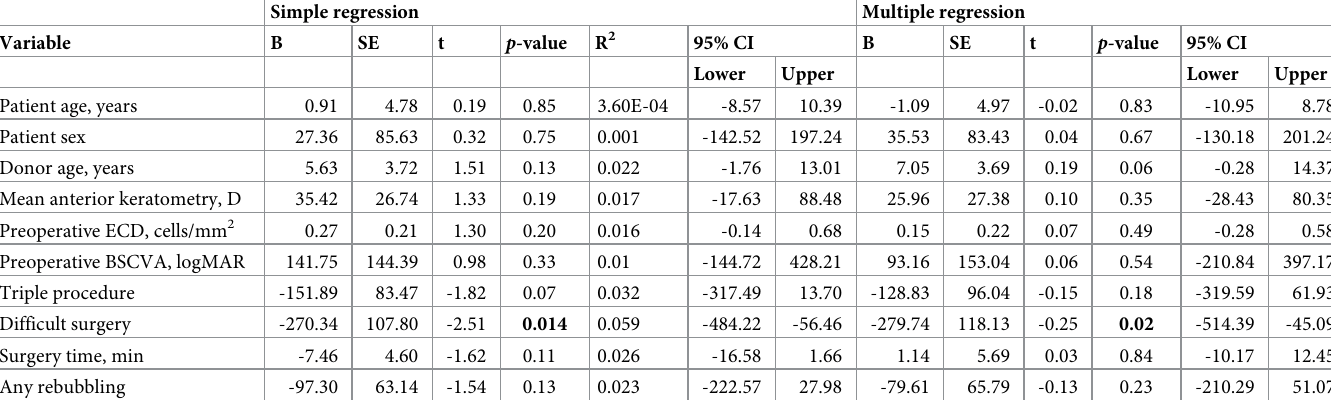
Table 3. Simple and multiple linear regression analysis of the relationship between endothelial cell density at 12 postoperative months and preoperative patient or graft or operative variables. Simple